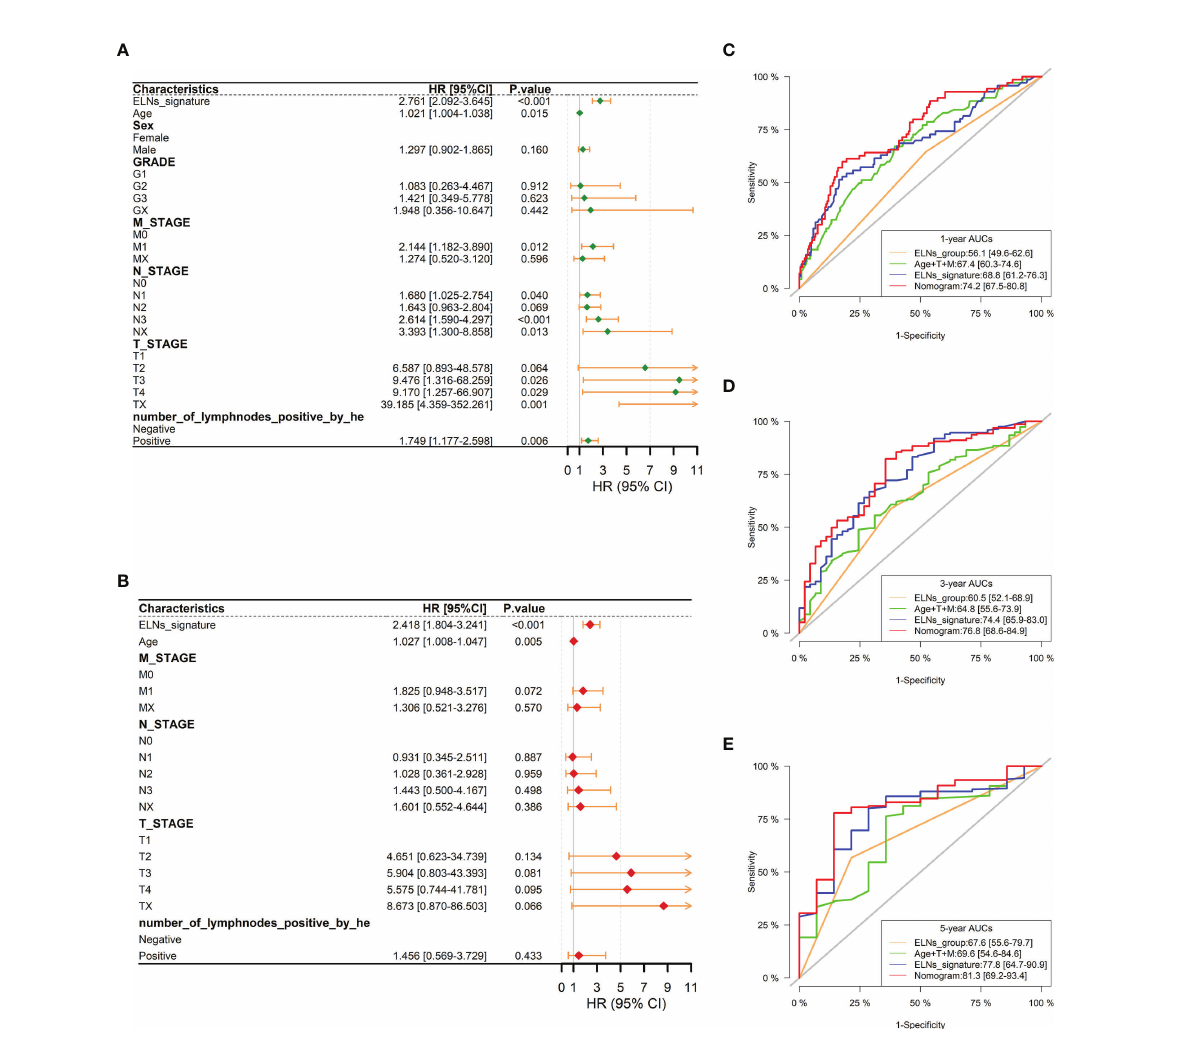
FIGURE 14 Prognostic analysis of the gastric cancer patients in the TCGA cohort. (A, B) Forest plots of univariate and multivariate Cox regression analysis between the ELNs signature and clinicopathological characteristics regarding OS in the TCGA cohort. (C – E) Time-dependent receiver operating characteristic analyses were constructed by the ELNs signature, ELNs group, age + T stage + M stage, etc., to show their prognostic ability in the TCGA cohort. ELNs, the number of lymph nodes examined; OS, overall